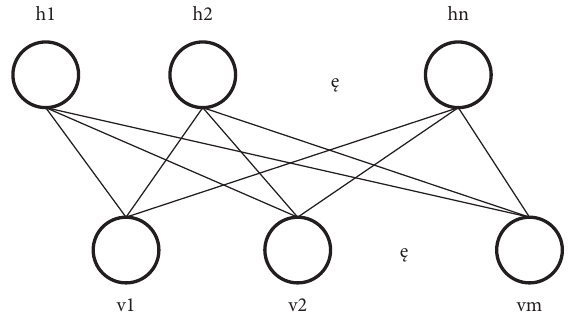
Figure 1: Te structure of the RBM